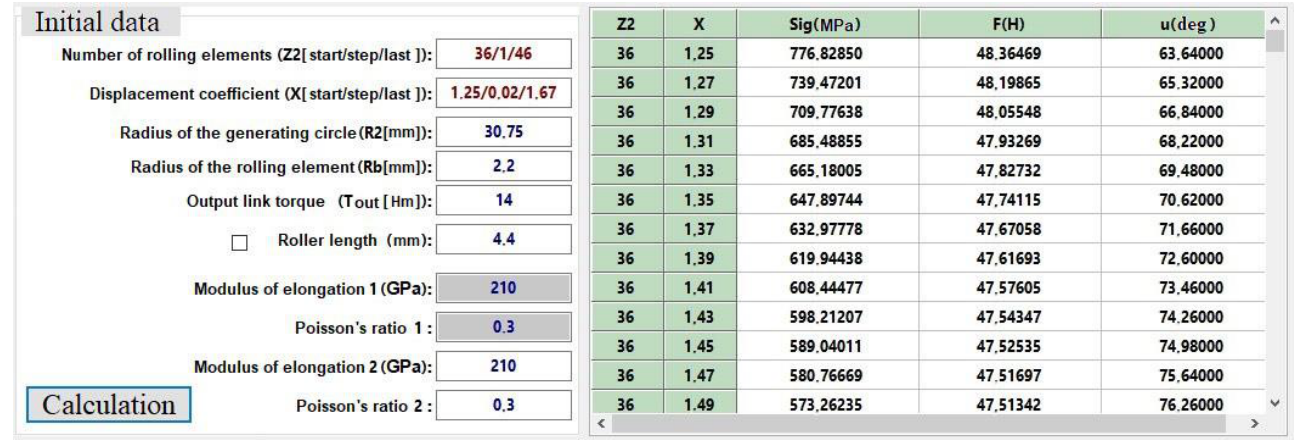
Figure 5. Interface of the program for automated calculation of the transmission force parameters with intermediate rolling elements and a free cage according to the developed algorithm.